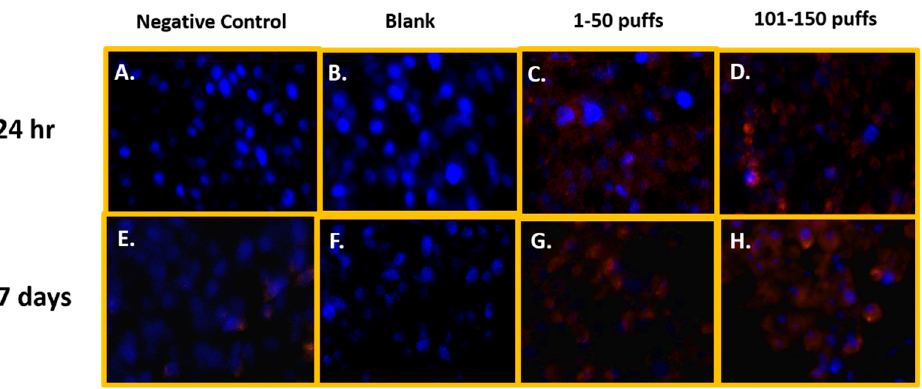
Figure 1. Qualitative ROS generation in SAEC after 24 h and 7 days of ENDS aerosol exposure at two different device-aging stages. At 24 h, Juul Virginia Tobacco exposures elicited significant levels of ROS ( C , D ) in comparison to the negative and blank control ( A , B ) at both puff fractions 1–50 and 101–150. After 7 days of repeated JUUL exposure, each puff fraction elevated ROS levels ( G , H ) in SAEC relative to the negative and blank control ( E , F ).